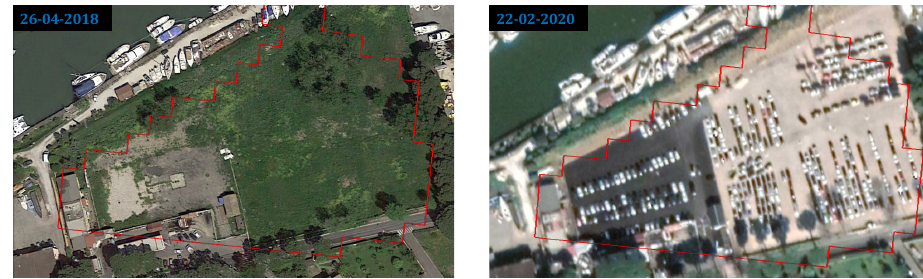
Figure 10. Scene comparison of the Rome Fiumicino airport area. The image on the left has very-high resolution, while the image on the right is acquired by the Sentinel-2 satellite mission. The algorithm correctly detects a new parking area in the